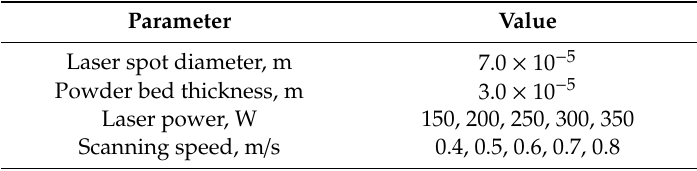
Table 3. Related parameters of this experiment.